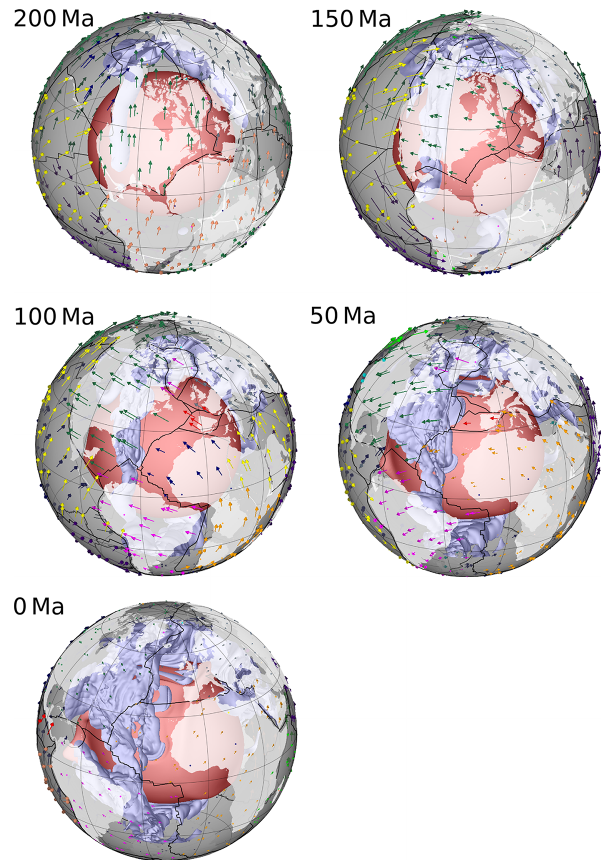
Figure 1. Schematic depiction of model run showing the evolution of the model from 200Ma to present day. The velocity field as denoted by the coloured arrows is generated by the plate tectonic reconstruction software GPlates based on the Earthbyte 2013 plate model (see text). This velocity field is used as a time-dependent velocity boundary condition for the TERRA model runs. The model temperature field within the lower mantle is shown in terms of the 2000 and the 2800K isotherm depicted as blue and red isosurfaces, respectively.